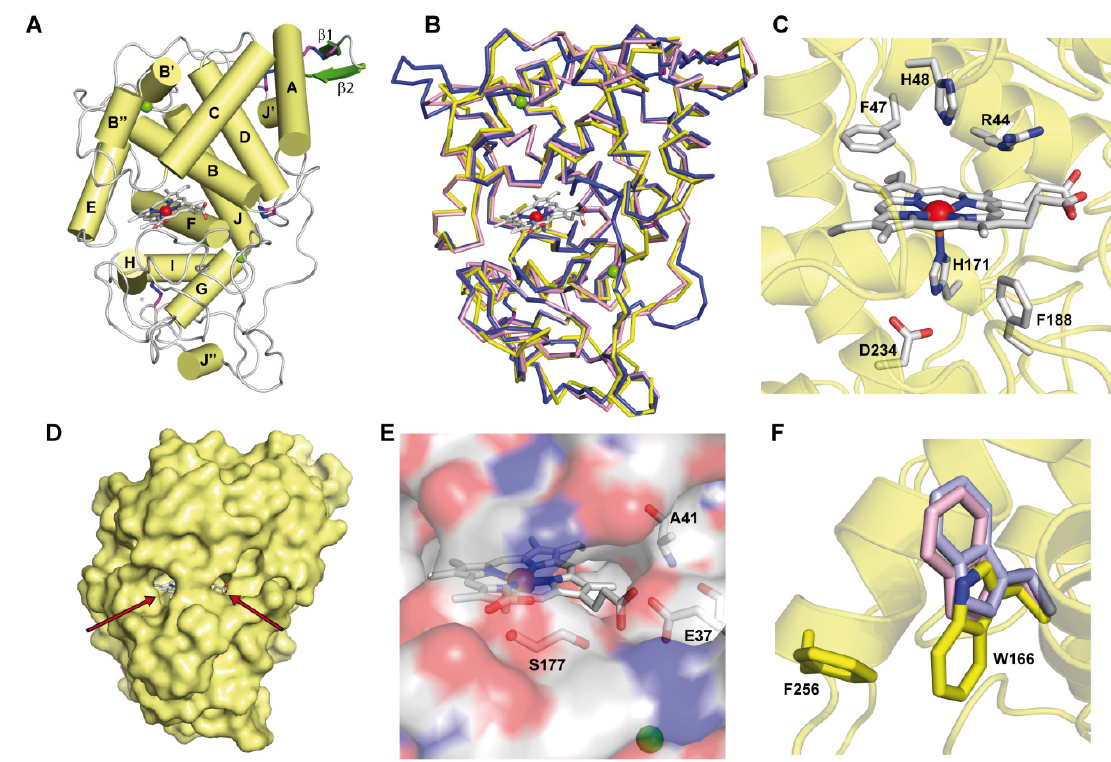
Figure 2. Crystal structure of ApeLiP. ( A ) Scheme of the overall structure showing 14 α -helices (yellow cylinders) and two small antiparallel β -strands (green), the heme cofactor (CPK sticks) with the iron center (red sphere), two structural calcium ions (green spheres), and four disulphide bonds (purple-blue sticks) (PDB entry 7OO5). ( B ) Structural alignment of the ApeLiP backbone (yellow) with the backbones of P. chrysosporium LiPA (blue) and P. eryngii VPL (magenta) (from PDB entries 1B82 and 2BOQ, respectively) (heme and structural calcium ions are also shown). ( C ) Heme cavity typical of class-II peroxidases including His171, Asp234 and Phe188 at the proximal side (below the heme plane); and His48, Arg44 and Phe47 at the distal side (above the heme plane) of ApeLiP. ( D ) Protein surface with indication (arrows) of two access channels to the heme cofactor. ( E ) Small access channel located on the heme propionates, with Ala41, Glu37 and Ser177 occupying the positions of the cation ligands in MnP and VP enzymes. ( F ) Superimposition of ApeLiP (yellow sticks), P. chrysosporium LiPA (blue), and P. eryngii VPL (magenta) catalytic tryptophans.